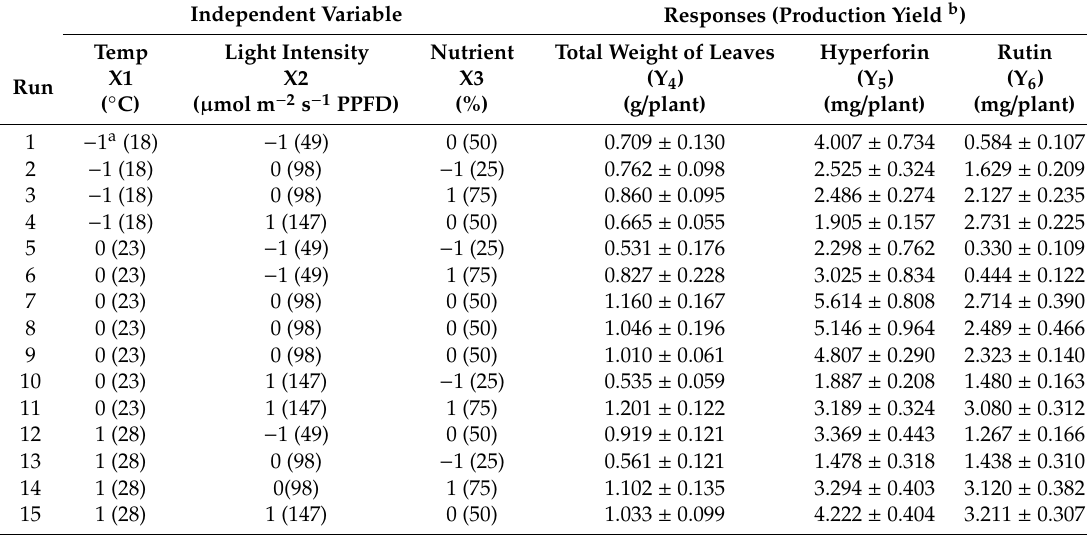
Table 4. Box-Behnken design in coded and actual levels of variables and the response